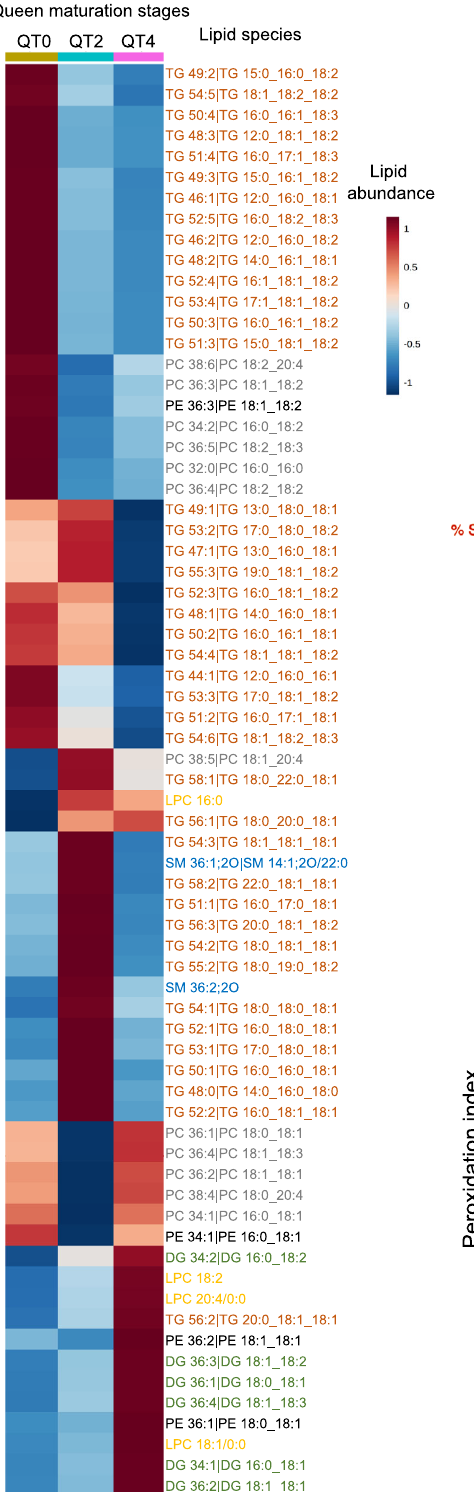
fatty acids (SFA) in fat bodies of QT0, QT2, and QT4. PUFA/ MUFA/SFA proportions in fat bodies of QT2 and QT4 were signi fi cantly different from QT0 (PERMANOVA, P value